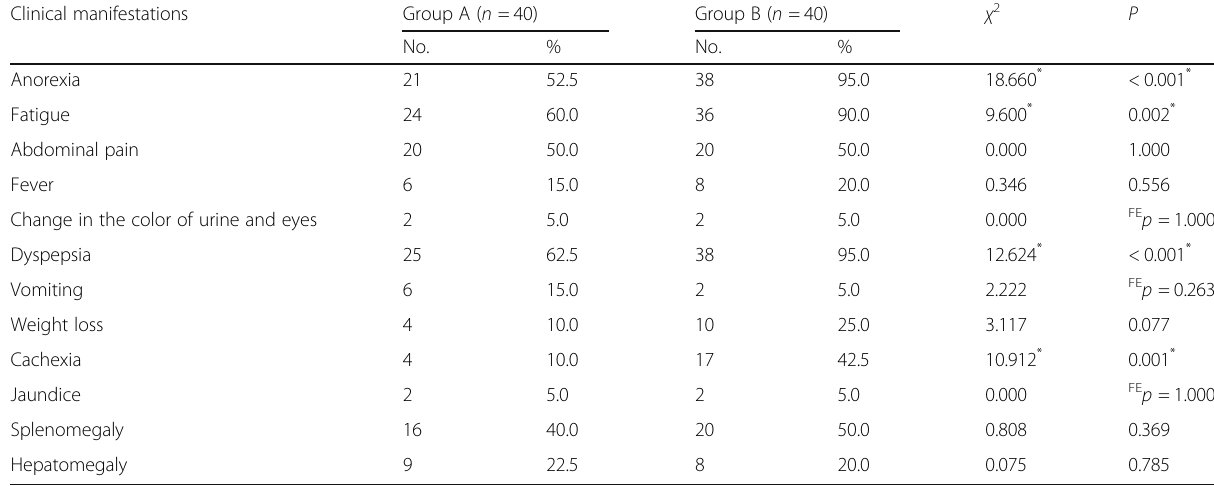
Table 1 Comparison between the two studied groups according to clinical manifestations Clinical